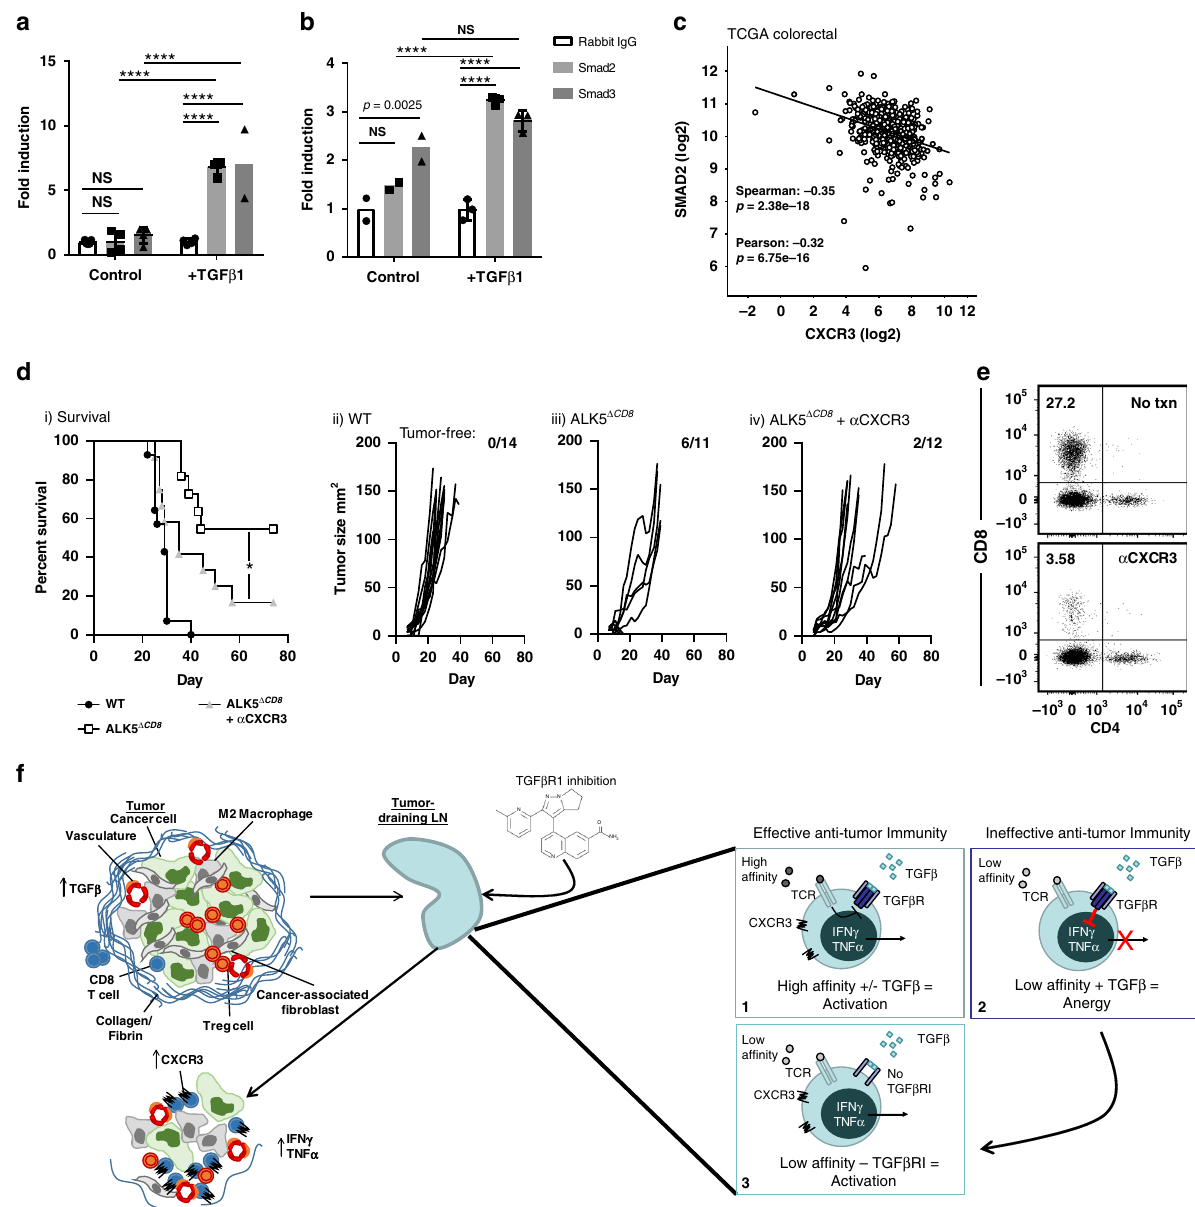
Fig. 5 TGF β -mediated suppression of CXCR3 limits CD8 + T cell chemotaxis and anti-tumor effect. ChIP was carried out using human Jurkat cells ( a ) and mouse primary CD8 + T cells ( b ) with anti-SMAD2 and anti-SMAD3 antibodies + / − TGF β 1 treatment, n = 2 – 5 technical replicates/condition. Experiment shown is representative of 3 independent experiments, displayed as mean + / − SD. **** p < 0.0001 using one-way ANOVA with Sidak ’ s multiple comparison correction. c Linear regression analysis of SMAD2 and CXCR3 gene expression levels from a cohort of TCGA colorectal cancer patients. P -values derived from Spearman and Pearson correlations. d MC38 survival (i) and tumor growth curves (ii – iv) in WT ( n = 14), ALK5 Δ CD8 ( n = 11) , and ALK5 Δ CD8 + α CXCR3 blocking antibody ( n = 12). The ratio of cured/total mice in each group is in the upper right. Shown is a composite of two independent experiments. P -value derived from log-rank test. * p = 0.0388. e Representative FACS plots of tumors from one C57BL/6 mouse each from untreated or α CXCR3 treated groups harvested 4 days after the last dose. Shown is CD4 and CD8 expression gated on viable CD45 + CD3 + cells. f Schematic representing hypothesis for LY2157299 mechanism of action. Naïve T cells exposed to LY are more susceptible to activation by low-avidity antigen in the lymph node. CXCR3 is upregulated upon activation, and by loss of TGF β -mediated suppression, which allows for better homing to CXCR3 ligands produced in the tumor microenvironment endogenously and following radiation. Once in the tumor, those TGF β -resistant CD8 T cells have improved